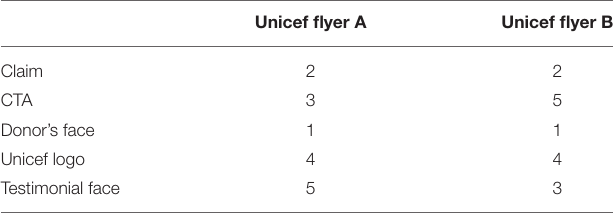
TABLE 3 | Sequence of visualization of area of interest on Unicef